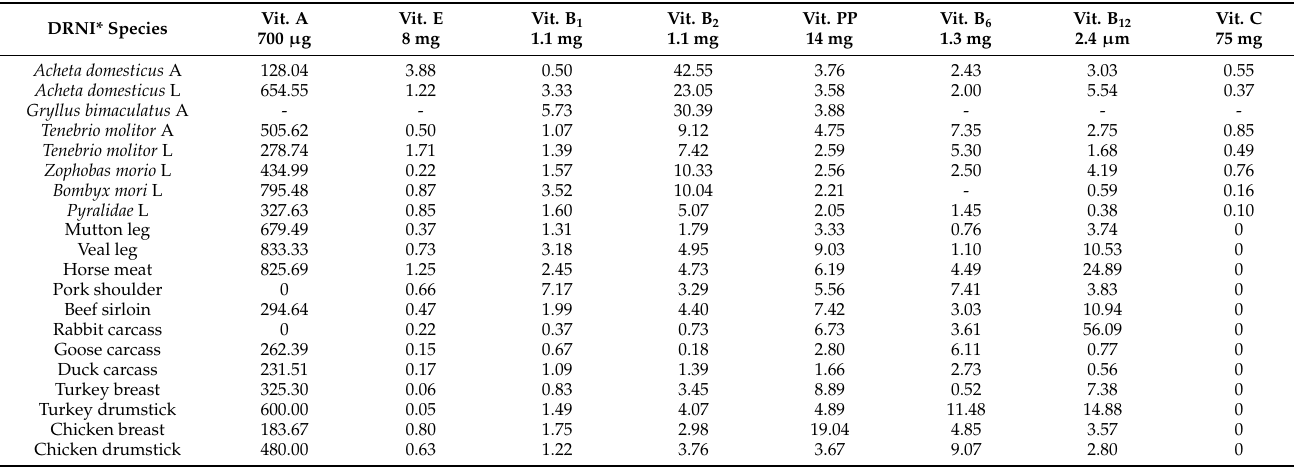
Table 9. INQ values of selected vitamins following the demand of women (31–50 years old, bodyweight 45 kg, moderate physical activity)